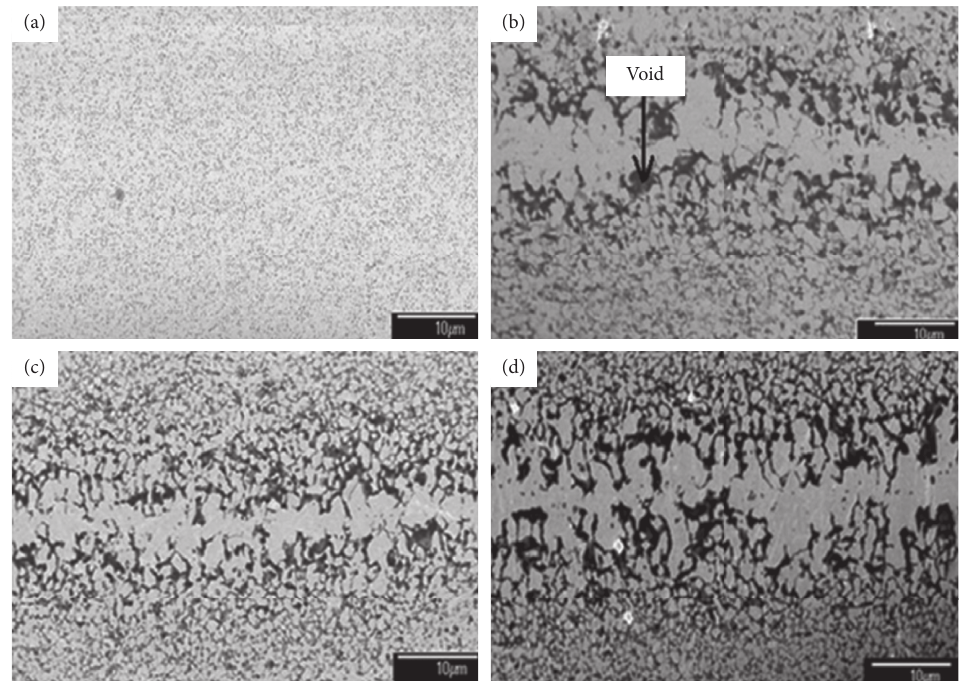
Figure 10: SEM images of Au-Si eutectic alloy: (a) without thermal aging and after (b) 100h, (c) 300 h, and (d) 500h of thermal aging at 300 ° C [47]. Table 3: Shear strength of Au-Si eutectic alloys with Cu/Au and ENIG UBM before and after thermal aging at 300 ° C for various durations